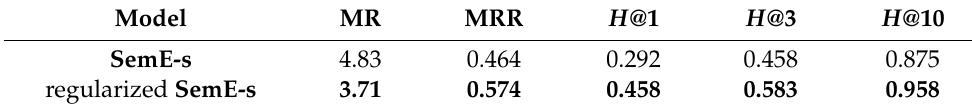
Table 4. Testing results on SemE-s model and logic regularized SemE-s